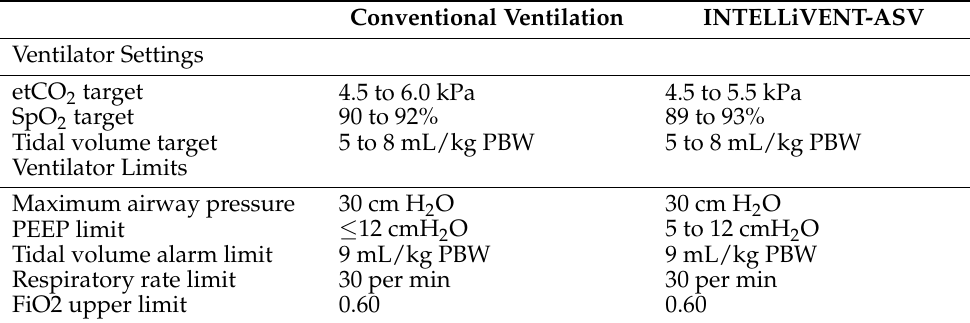
Table 1. Ventilator settings and